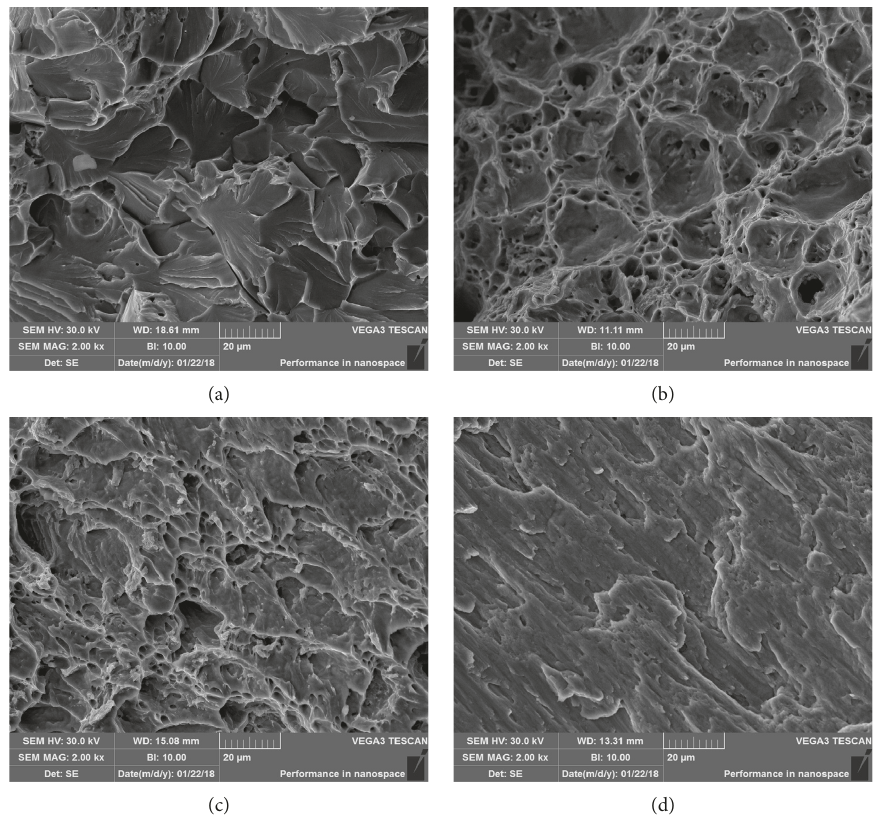
Figure 1: The SEM images of the typical fracture surfaces of four different fracture mechanisms: (a) quasicleavage fracture, (b) normal fracture with void, (c) shear fracture with void, and (d) shear fracture without